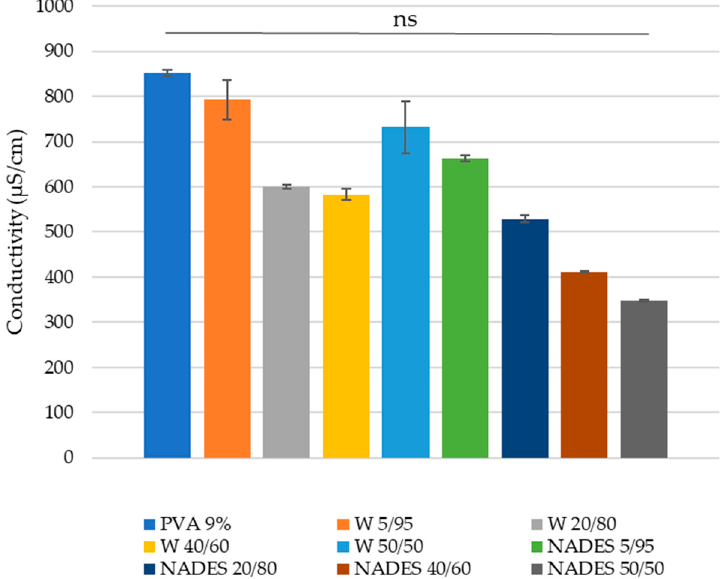
Figure 3. Conductivity ( μ S/cm) of the emulsions used to form nanofibers. ns—non ‐ significant for p ‐ value of 0.05. p -value of